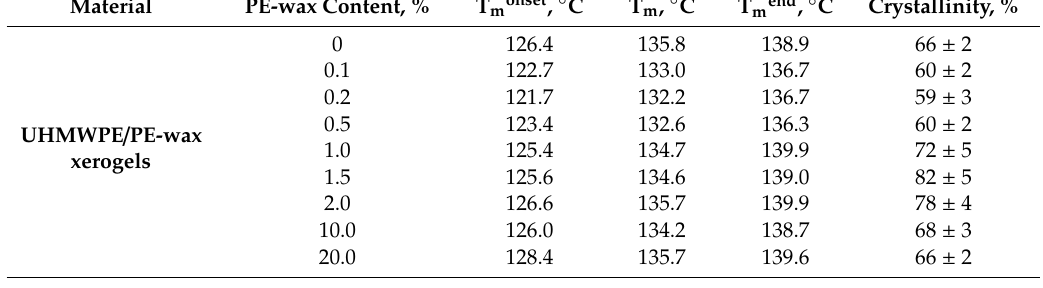
Table 3. DSC test results for the UHMWPE / PE-wax xerogels depending on PE-wax content ( ± the standard deviation).